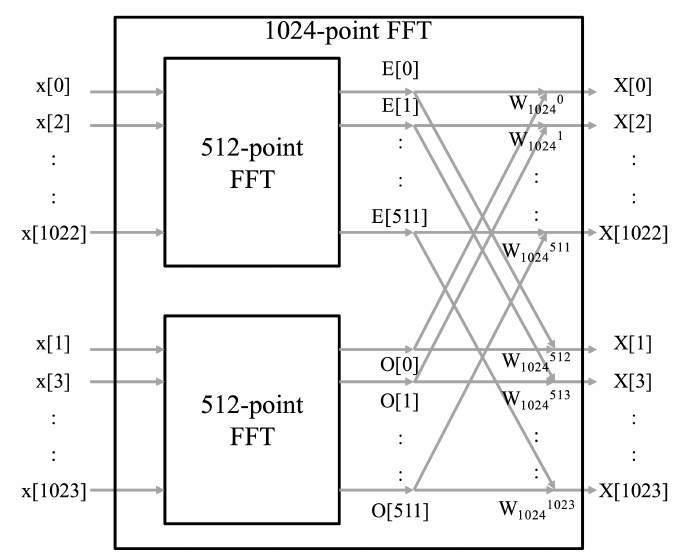
Figure 5. Structure of fast Fourier transform (FFT) using radix-2 algorithm. ( x [ k ] is time-domain input with 1024 samples, X [ k ] is the 1024-point FFT output, E [ k ] and O [ k ] are the 512-point FFT outputs with even- and odd-indexed samples, respectively, and W k